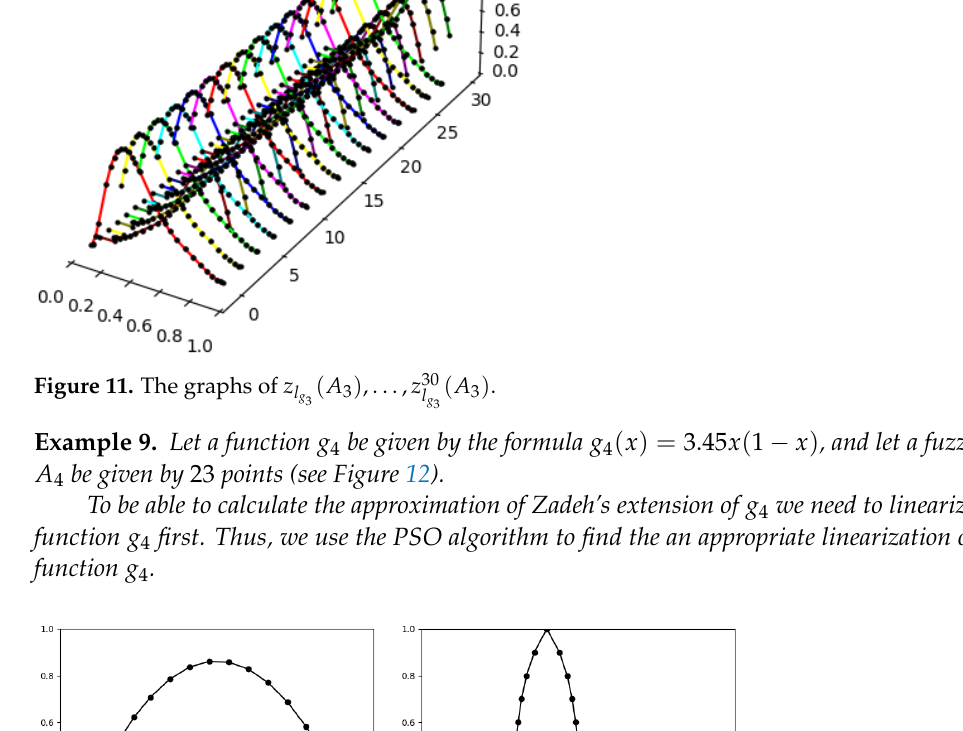
Figure 12. The graphs of the linearized function l g given by 23 points ( right ).